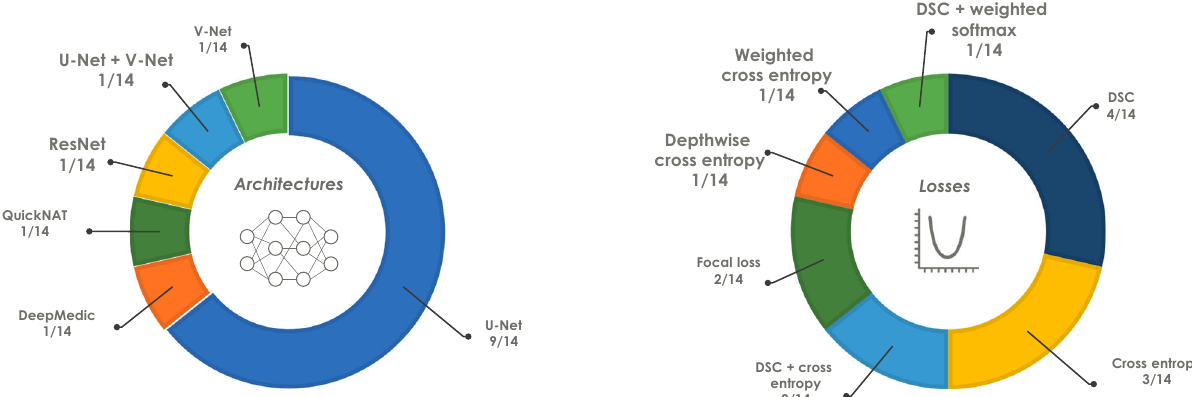
Fig. 2 Base network architectures (left) and loss functions (right) used by the participants of the 2018 Decathlon challenge who provided full algorithmic information ( n = 14 teams). Network architectures: DeepMedic — Ef fi cient multi-scale 3D CNN with fully connected CRF for accurate brain lesion segmentation 45 , QuickNAT — Fully Convolutional Network for Quick and Accurate Segmentation of Neuroanatomy 44 , ResNet — Deep Residual Learning for Image Recognition 15 , U-Net — Convolutional Networks for Biomedical Image Segmentation 11 , V-Net — Fully Convolutional Neural Networks for Volumetric Medical Image Segmentation 43 . DSC Dice Similarity Coef fi